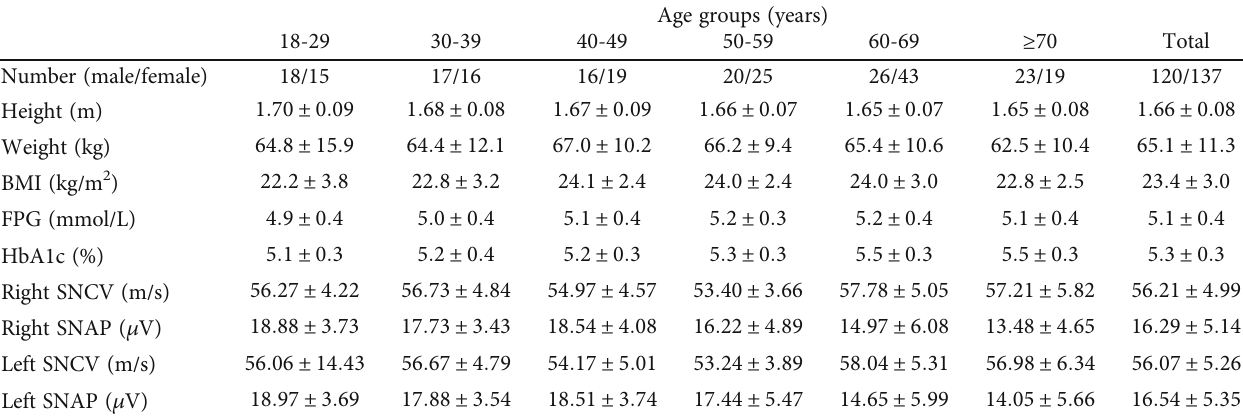
Table 1: Demographic characteristics of the participants.